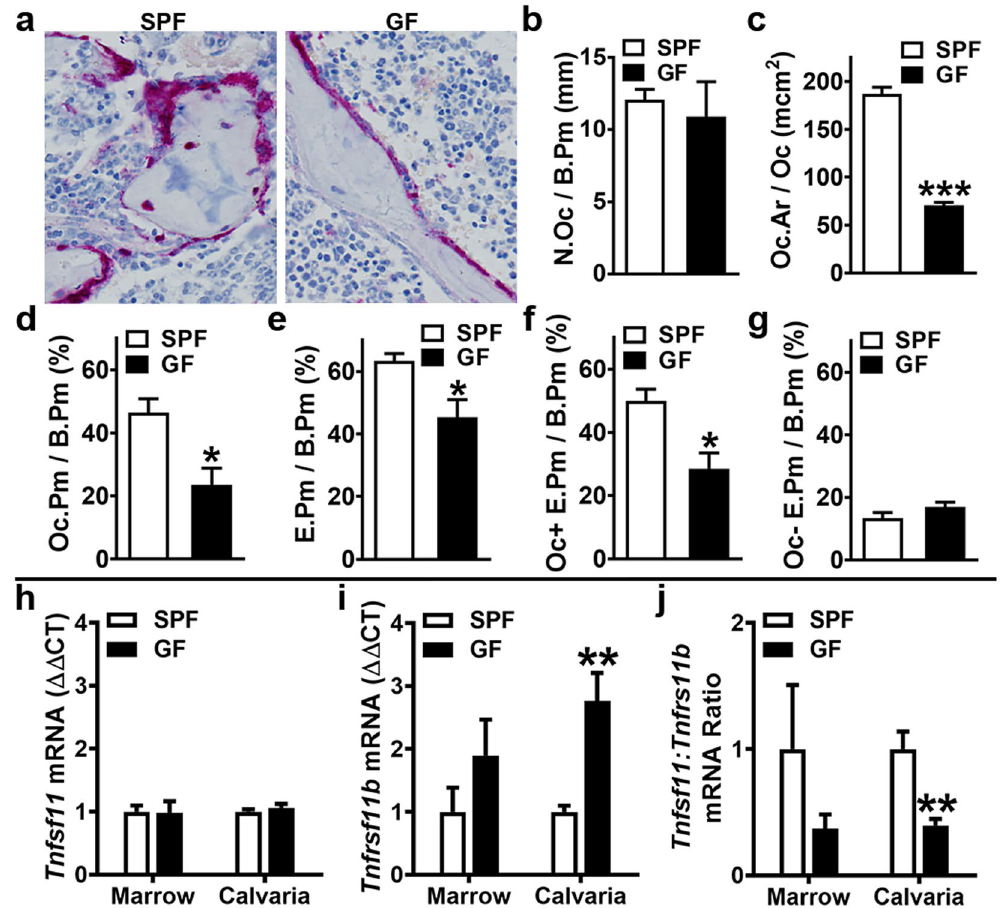
Figure 3. Commensal microbiota in vivo regulation of osteoclastogenesis. 12 week-old male SPF & GF mice were euthanized; ( a – g ) femurs harvested for histomorphometric analyses (n = 4/gp), and ( h – j ) bone marrow and calvaria were harvested for gene expression analysis (n = 4/gp). ( a – g ) Histomorphometric analyses of osteoclast cellular endpoints and resorbed bone were performed in the trabecular bone secondary spongiosa of tartrate-resistant acid phosphatase (TRAP) stained distal femur sections; TRAP + cell lining bone with ≥ 3 nuclei designated an osteoclast. ( a ) Representative images of TRAP-stained secondary spongiosa (400 × ). ( b ) N.Oc/B.Pm = osteoclast number per bone perimeter. ( c ) Oc.Ar/Oc = average osteoclast area. ( d ) Oc.Pm/B. Pm = osteoclast perimeter per bone perimeter. ( e ) E.Pm/B.Pm = eroded perimeter per bone perimeter. ( f ) Oc + E.Pm/B.Pm = osteoclast-positive eroded perimeter per bone perimeter. ( g ) Oc-E.Pm/B.Pm = osteoclast- negative eroded perimeter per bone perimeter. ( h – j ) qRT-PCR analysis in bone marrow and calvaria to assess alterations in the RANKL/OPG Axis. ( h ) Tnfsf11(Rankl) mRNA in bone marrow and calvaria. ( i ) Tnfrsf11b(Opg) mRNA in bone marrow and calvaria. ( j ) Tnfsf11(Rankl) : Tnfrsf11b(Opg) ratio in bone marrow and calvaria. Relative quantification of mRNA was performed via the comparative C T method ( ΔΔ CT); Gapdh was utilized as an internal control gene; data expressed as fold difference relative to SPF. Data reported as mean ± SEM. * p < 0.05 vs. SPF; ** p < 0.01 vs SPF; *** p < 0.001 vs